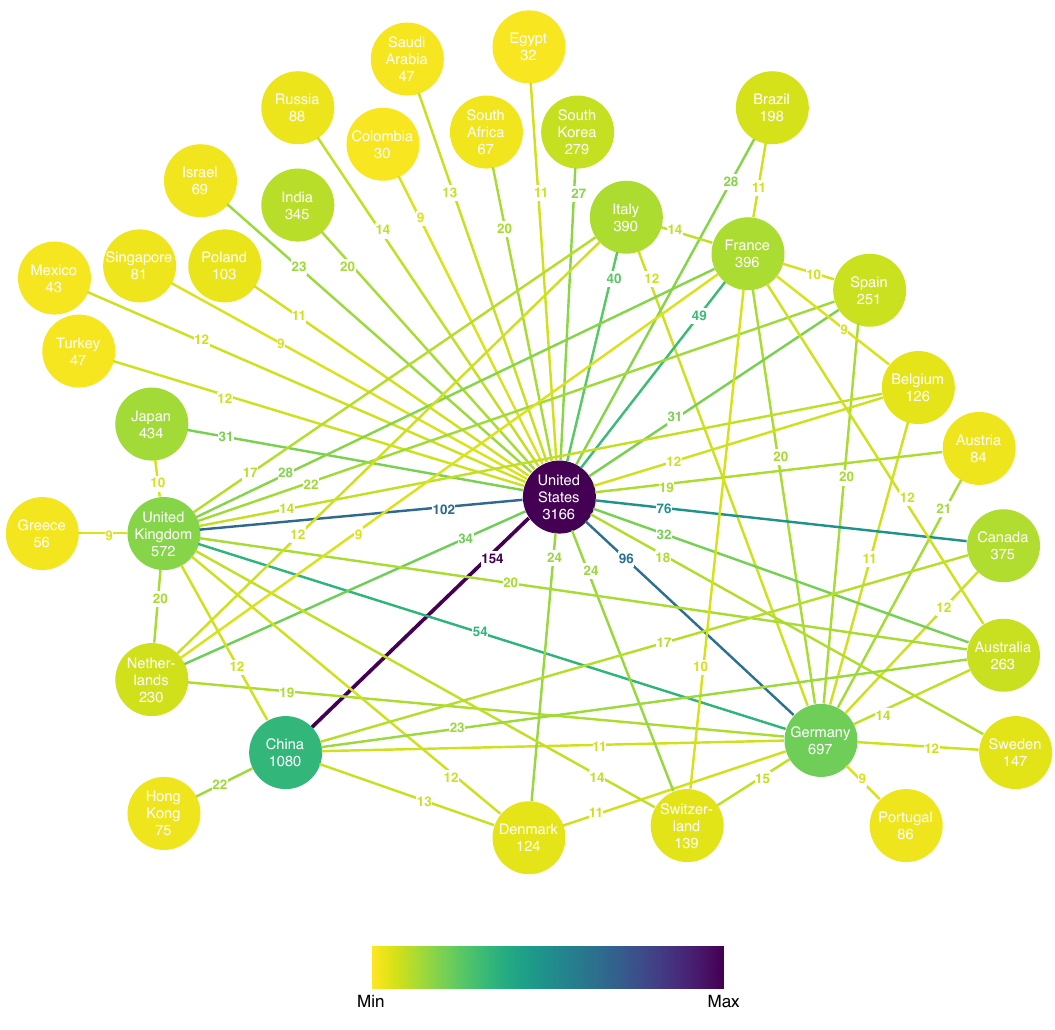
Figure 5. Number of research papers per country and collaboration links with the annotated number of joint